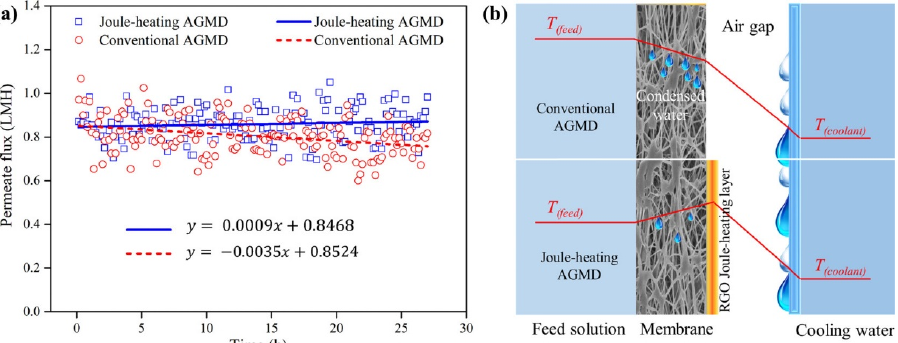
Figure 11. ( a ) Permeate flux of conventional air-gap membrane distillation (AGMD) and an AGMD equipped with rGO Joule-heating membrane in the orientation with rGO layer facing against air-gap side (Joule-heating AGMD). ( b ) The schematic diagram of temperature profiles of the conventional AGMD and Joule-heating AGMD. Reproduced with permission from [28].